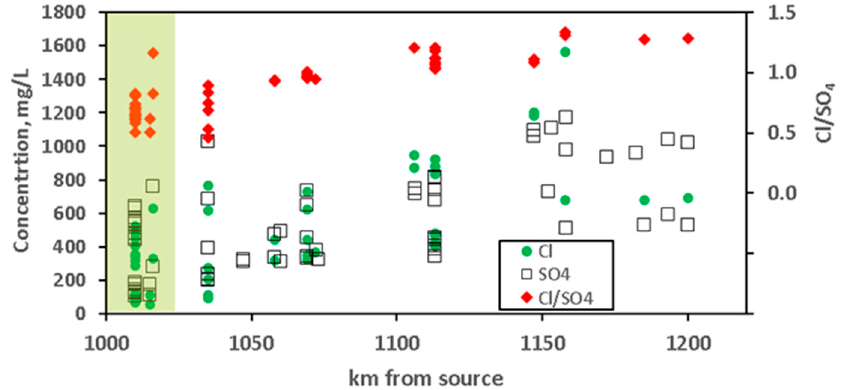
Figure 3. Plots of [SO 4 ], [Cl] and [SO 4 ]/[Cl] for all Rio Grande surface water samples used in this study, as a function of location indicated as km from the river source. Samples are from the terminus of Mesilla Valley (green shading) and the Hueco Bolsón (white area).